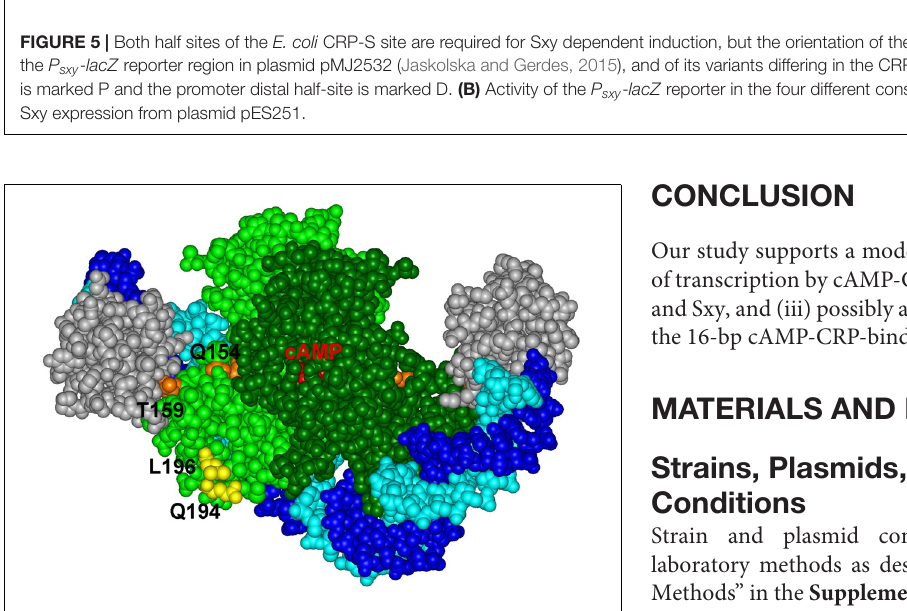
FIGURE 6 | Positions of CRP residues Q194 and L196 on the complex of the CRP dimer (light and dark green) with DNA (light and dark blue) and the alpha subunit of RNA polymerase (gray) (PDB: